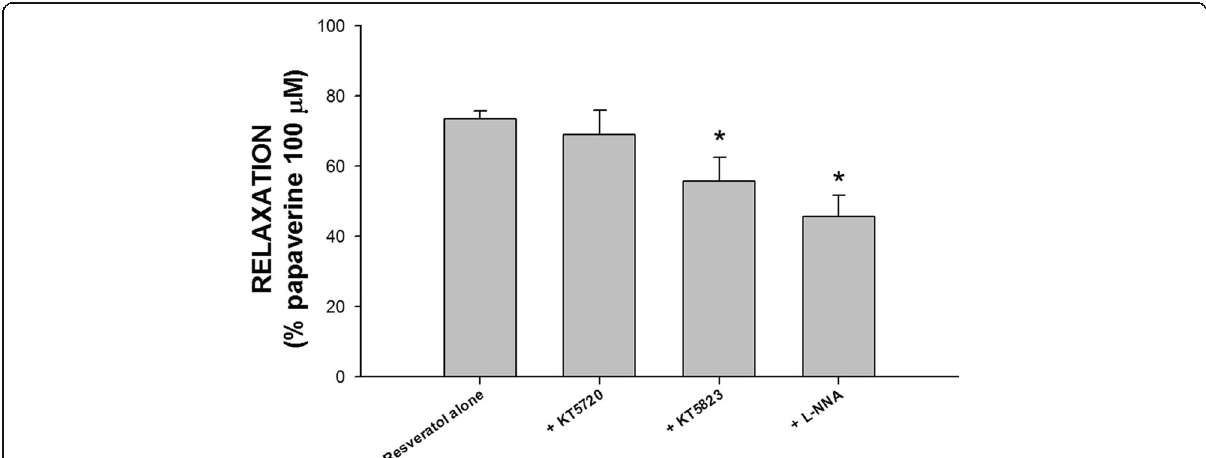
Fig. 4 The effects of KT 5720, KT 5823, and NG-nitro-L-arginine (L-NNA) on resveratrol-induced relaxation in the human gallbladder. KT 5720 (1 μ M) had no significant effect on resveratrol-induced relaxation of human gallbladder muscle strips ( p > 0.05, n = 6). In contrast, L-NNA (100 μ M) and KT